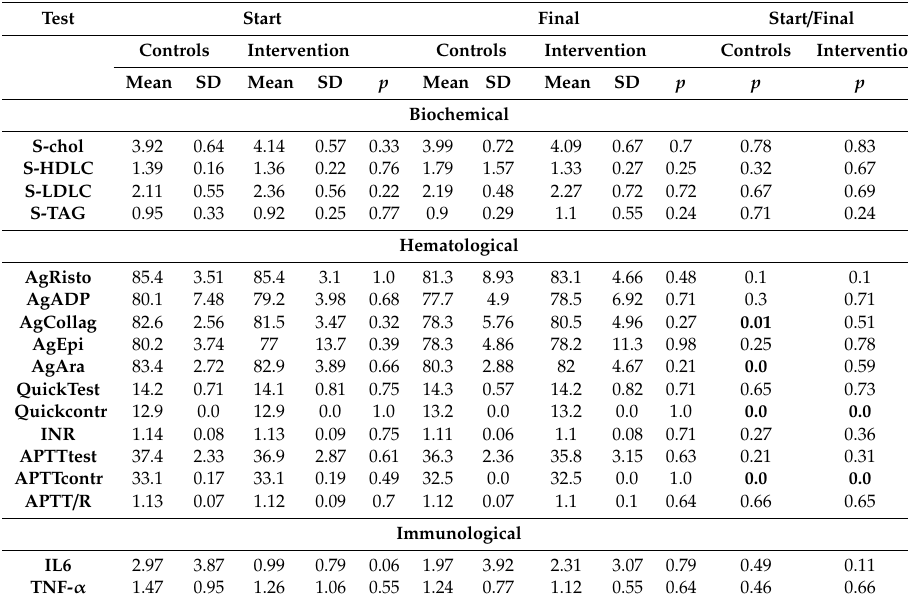
Table 4. Basic biochemical, hematological, and immunological laboratory test of blood